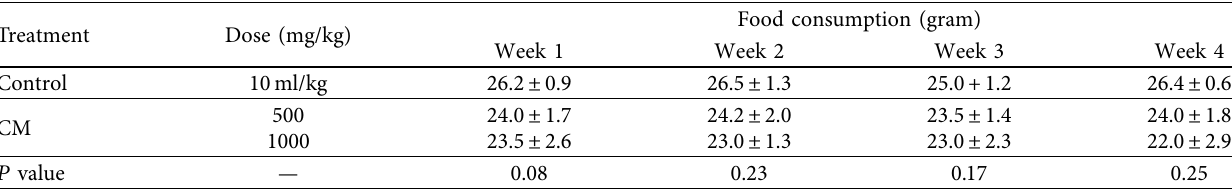
Table 2: Changes in food consumption of mice following treatment with essential oil of C. martini at 500mg/kg and 1000mg/kg b.w.